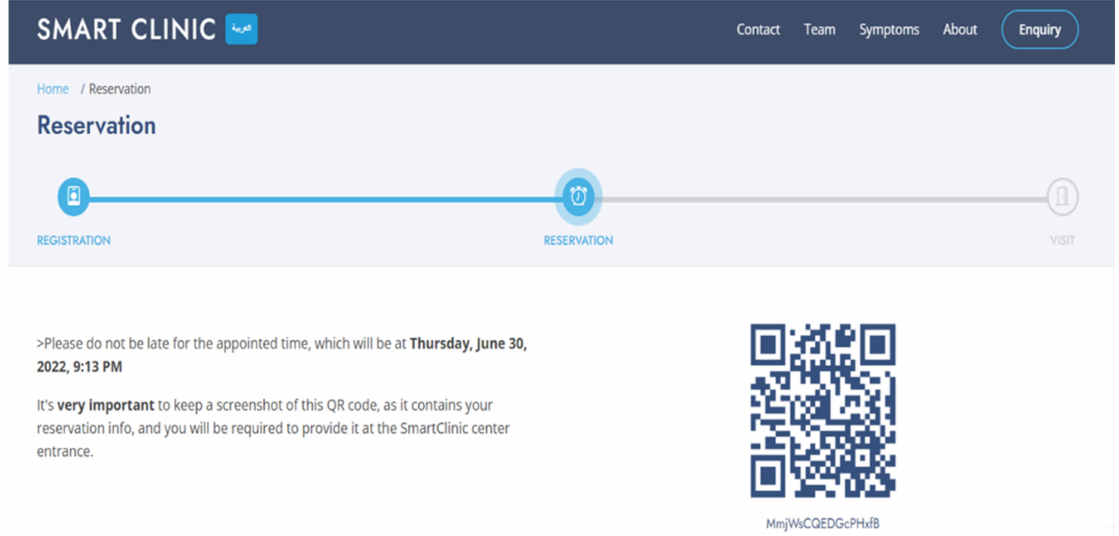
Figure 6. QR code